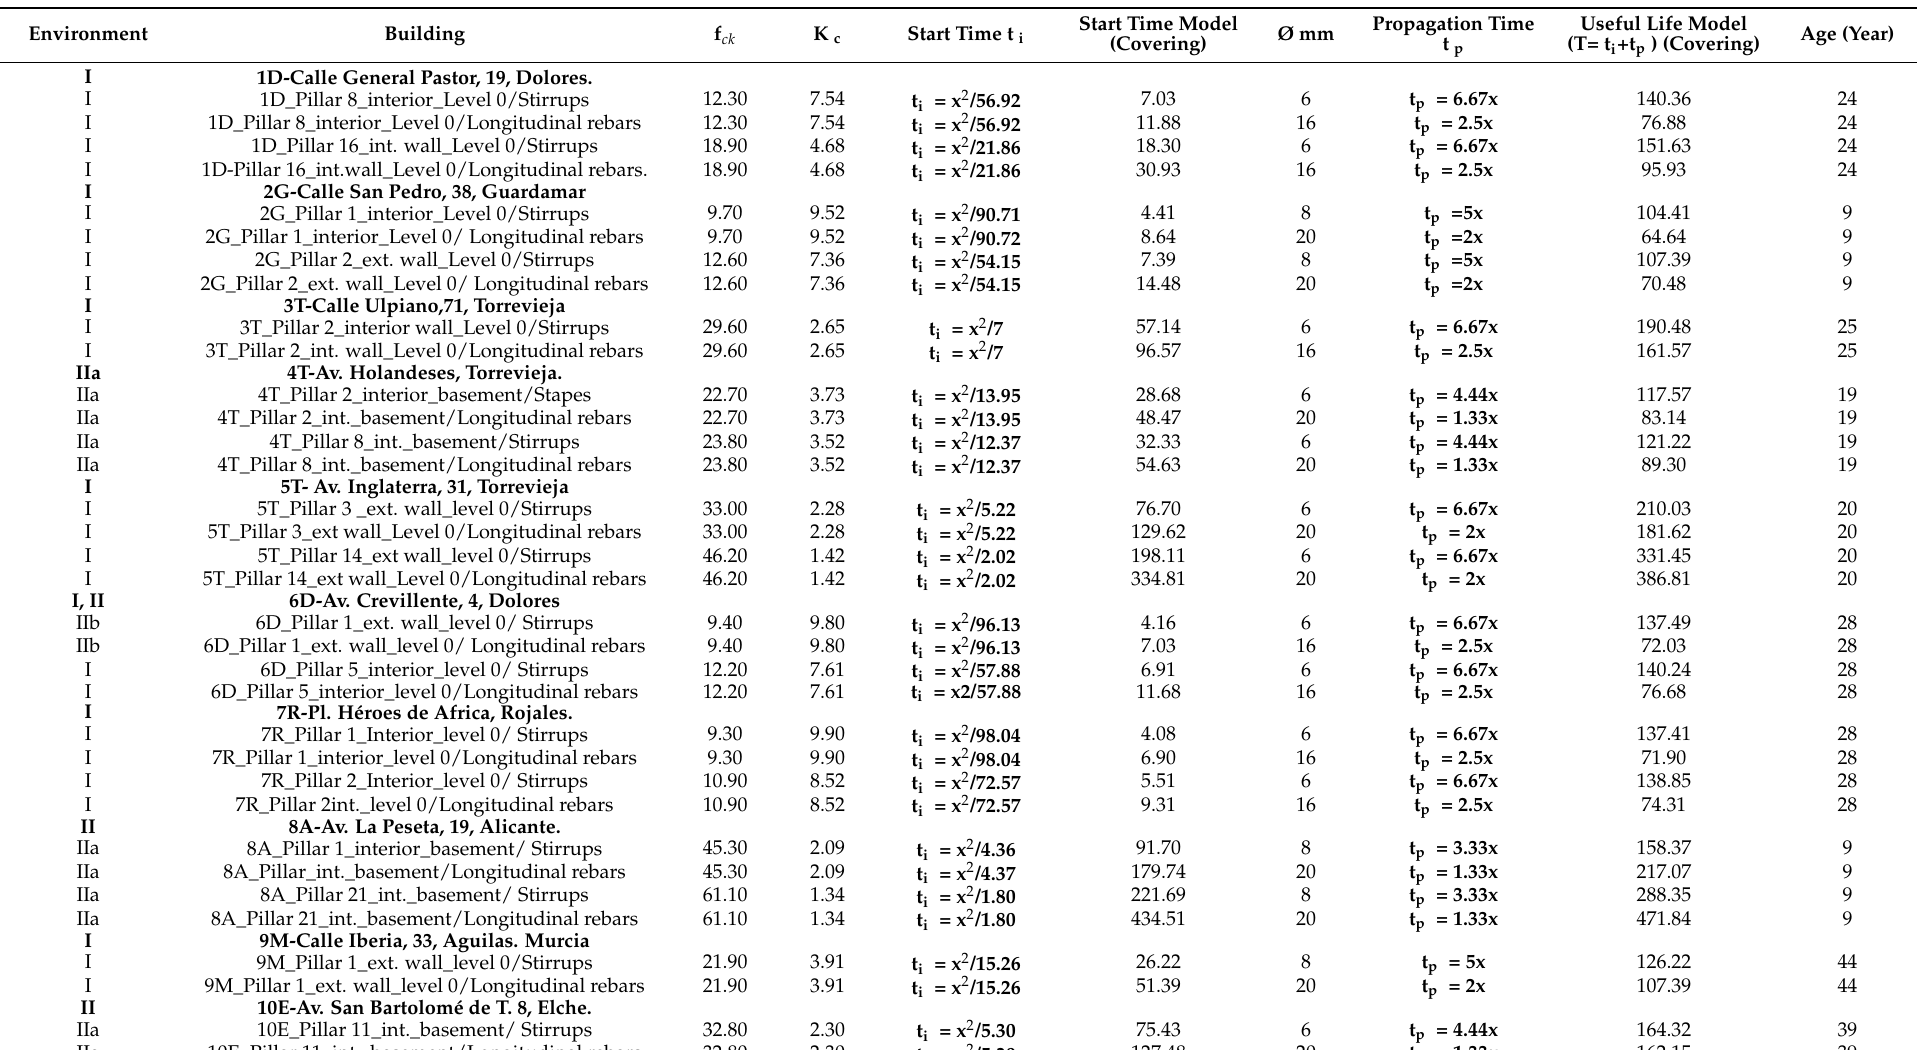
Table 6. Studied buildings. Initiation (start time) and propagation time corrosion model. Useful life